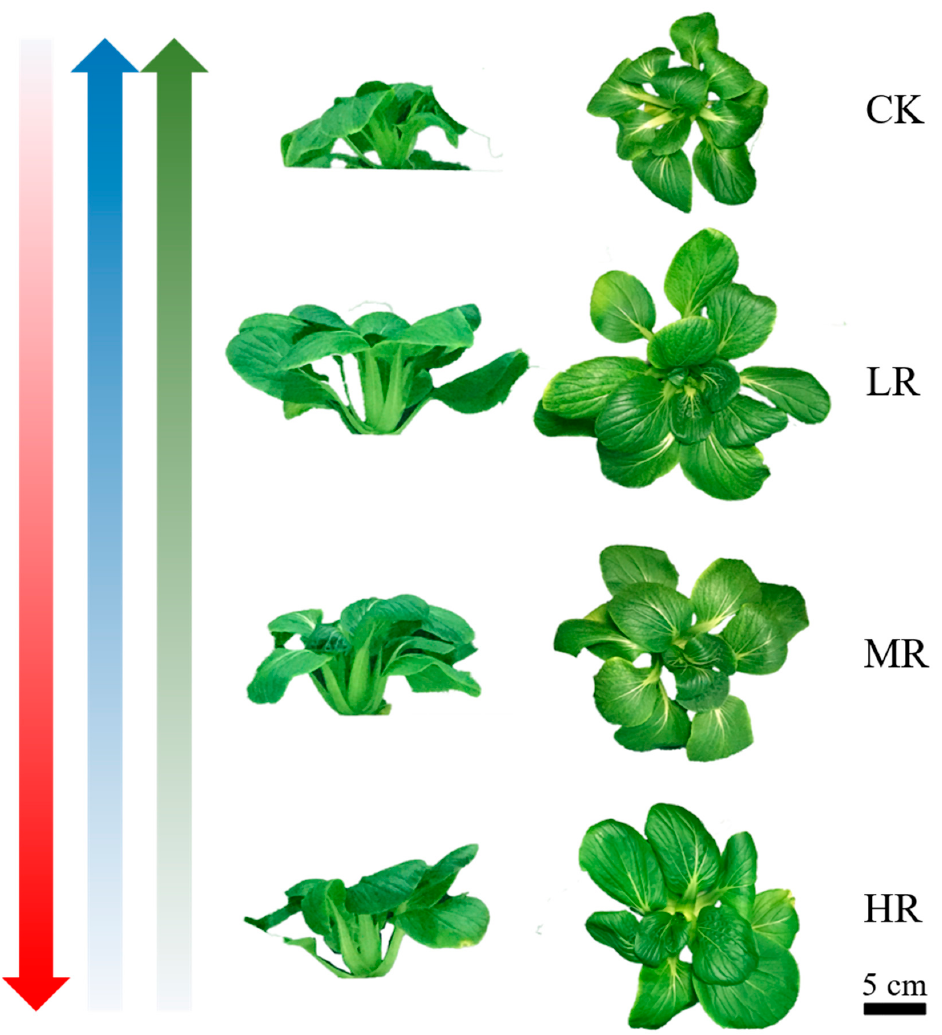
Figure 2. Pak choi morphology at 35 days after treatments. CK: only white light, LR: red:white = 1:2, MR = red:white = 1:1, LR = red:white = 2:1. The direction and color of the arrows indicate trends in the intensity of the different light qualities.